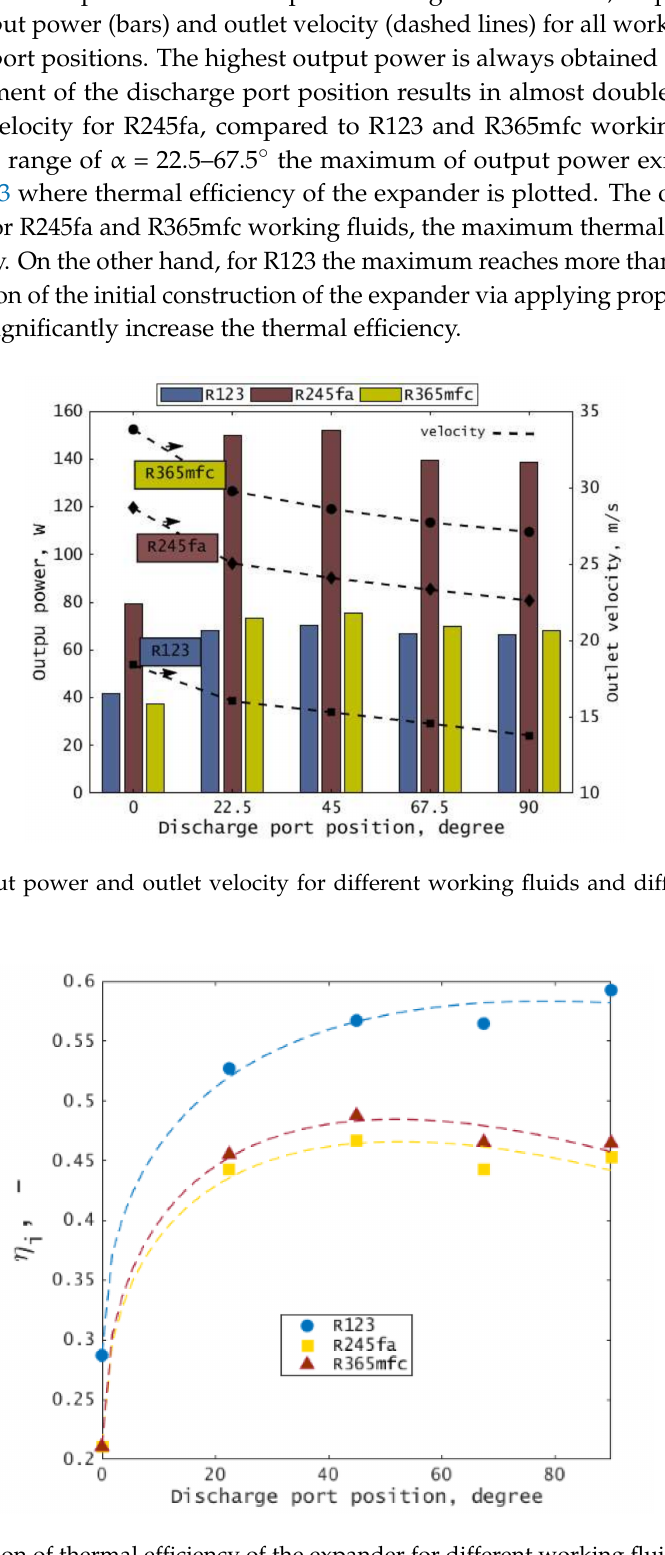
Figure 13. Variation of thermal efficiency of the expander for different working fluids and different outlet port